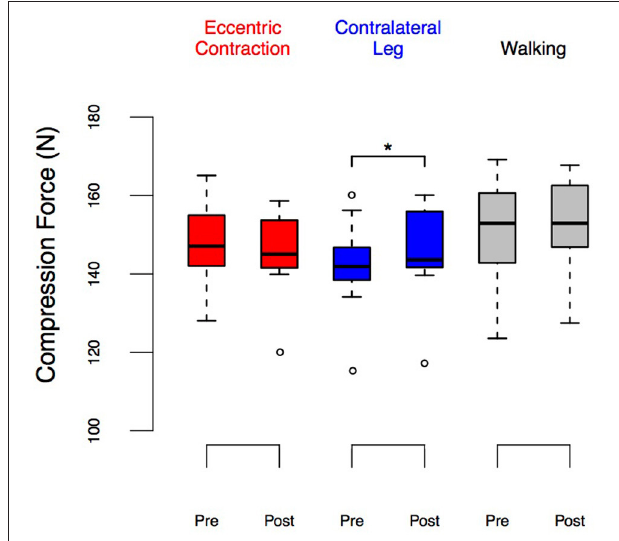
FIGURE 5 | LED force before and after eccentric contractions or walking in the Exposure group. Group performance is shown as box plots. The upper and lower ends of the box represent the upper and lower quartiles. The horizontal line inside the box represents the median. The whiskers show the range of adjacent values, representing the range of values not declared outliers. We observed a significant increase in LED force in the contralateral leg ( p = 0.037) and no changes in the exposed leg nor after walking. *Denotes significant change ( p <